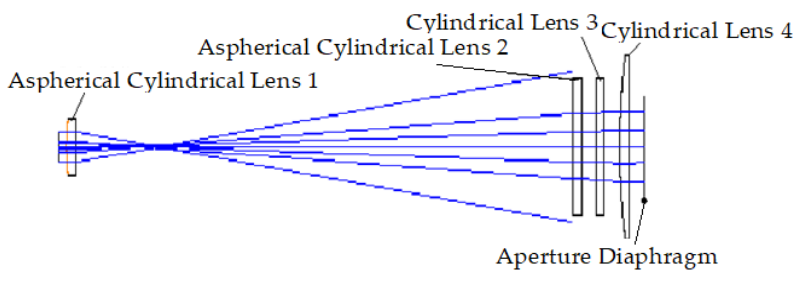
Figure 6. Optical structure diagram in the Y-direction.